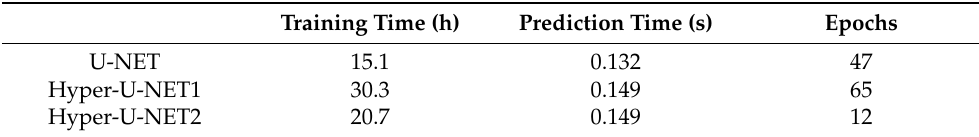
Table 2. Training and prediction time consumption of the different models.